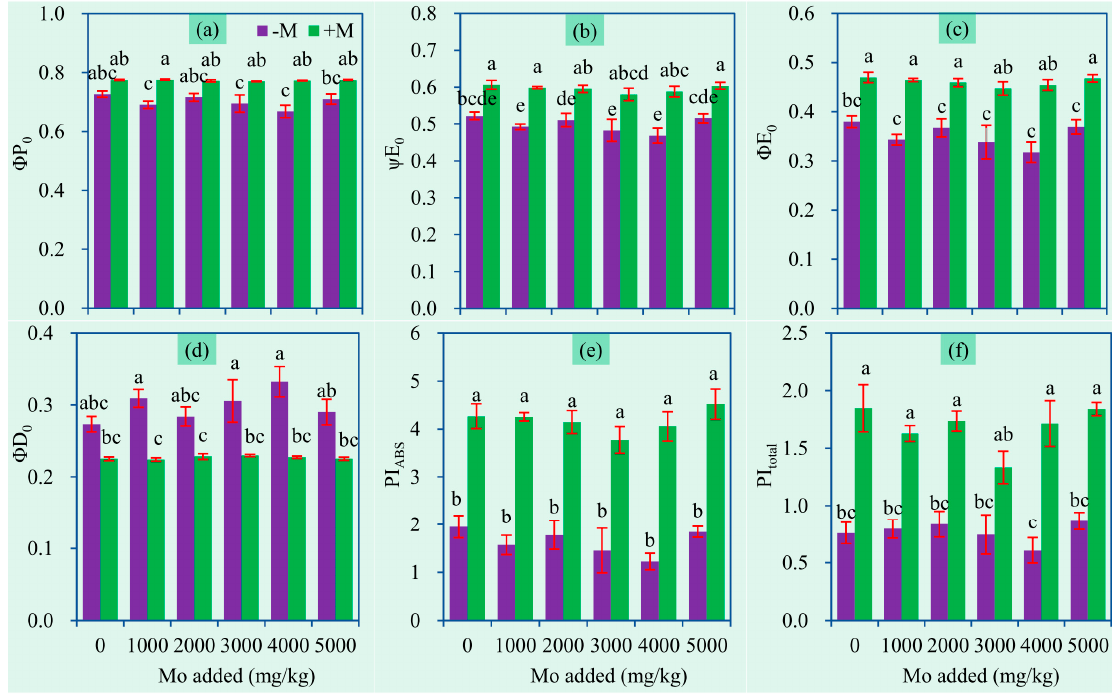
Figure 8. JIP-test parameters (mean ± SE, n = 4) of sweet sorghum exposed to different concentrations of Mo. ( a ) φ Po, ( b ) ψ Eo, ( c ) φ Eo, ( d ) φ Do, ( e ) PI ABS , ( f ) PI total . -M and +M represent non-AM inoculation and inoculation with Claroideoglomus etunicatum BEG168, respectively. Different letters over the bar represent significant differences between the means among different treatments using one-way ANOVA followed by Duncan’s multiple range test ( p < 0.05). The definitions of the parameters were shown in Table 2 and two-way ANOVA results were shown in Table 3.